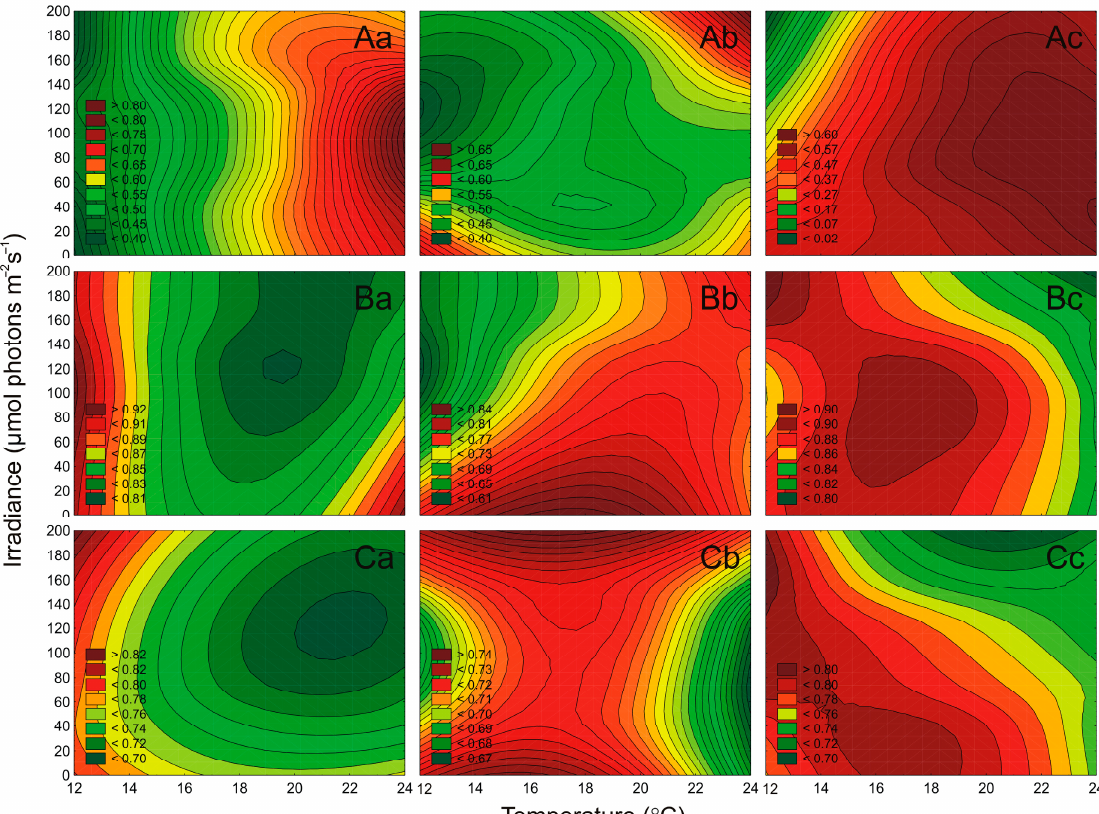
Figure 7. Changes in the maximum PSII quantum efficiency ( F v / F m ) obtained after 7 days of experiment for airborne cyanobacteria: Nostoc sp. ( Aa ), Synechococcus sp. ( Ab ), and Aphanothece sp. ( Ac ); airborne green algae: Oocystis sp. ( Ba ), Coccomyxa sp. ( Bb ), and Kirchneriella sp. ( Bc ); airborne diatoms: Nitzschia sp. ( Ca ), Amphora sp. ( Cb ), and Halamphora sp. ( Cc ) under different irradiance (µmol photons m –2 s –1 ) and temperature (°C) conditions.